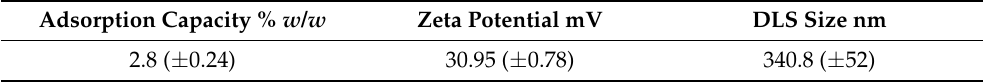
Table 1. Main characteristics of H2B/PLA-NPs selected for animal experiments.